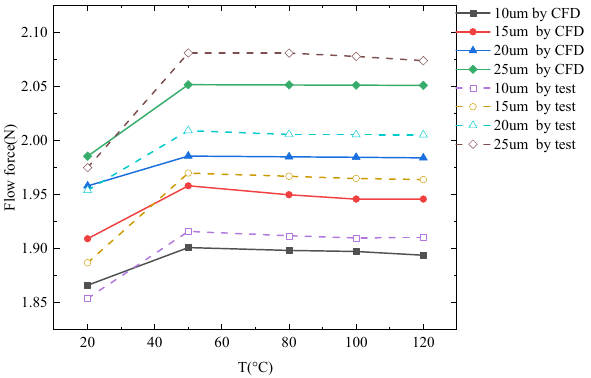
Figure 22. Influence of displacement and temperature variation on flow force.